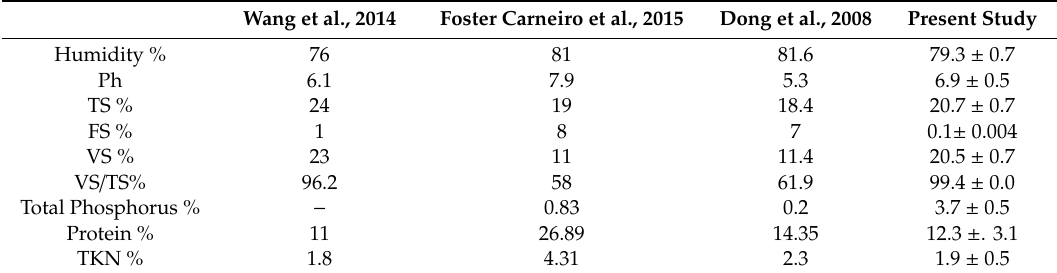
Table 1. Physical-chemical characteristics of